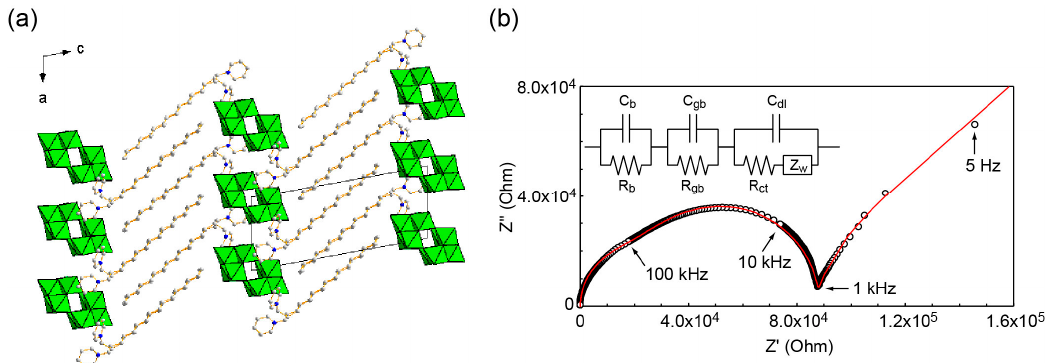
Figure 13. Crystal structure and conductive property of C 16 py–W 10 hybrid crystals. ( a ) Crystal packing; ( b ) Nyquist spectrum (open circles) at 423 K and simulated spectrum ( red line) based on an equivalent electronic circuit [127]. Reproduced with permission from Ito, T. et al. , Crystals; published by MDPI, 2012.